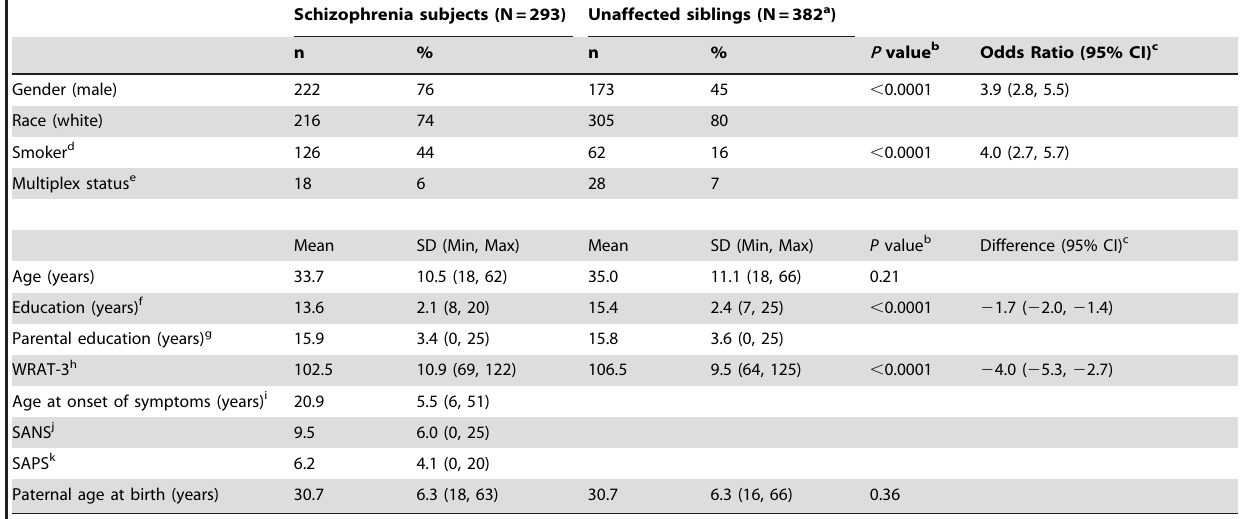
Table 1. Demographic and clinical characteristics of schizophrenia subjects and unaffected